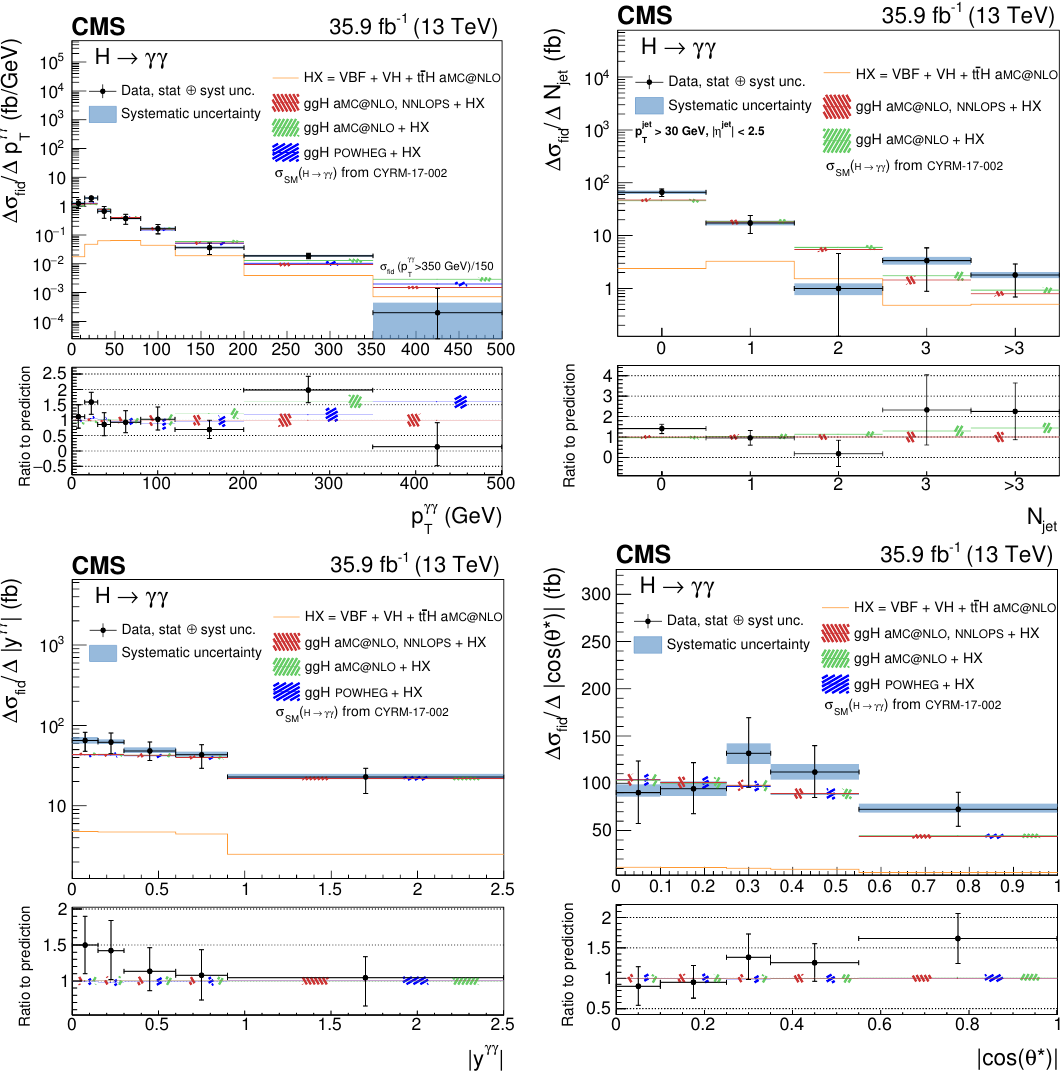
Figure 4 . Measurement of the di(cid:11)erential cross section (black points) as functions of p (cid:13)(cid:13) j y (cid:13)(cid:13) j , and j cos( (cid:18) (cid:3) ) j . The error bars indicate 1 standard deviation uncertainty. The systematic component of the uncertainty is shown by the blue band. The measurements are compared to di(cid:11)erent simulation programs (histograms) with their uncertainties (hatched areas), all normalized to the same theoretical predictions from ref. [13]. When the last bin of the distribution is an over(cid:13)ow bin, the normalization of the cross section in that bin is indicated in the (cid:12)gure.